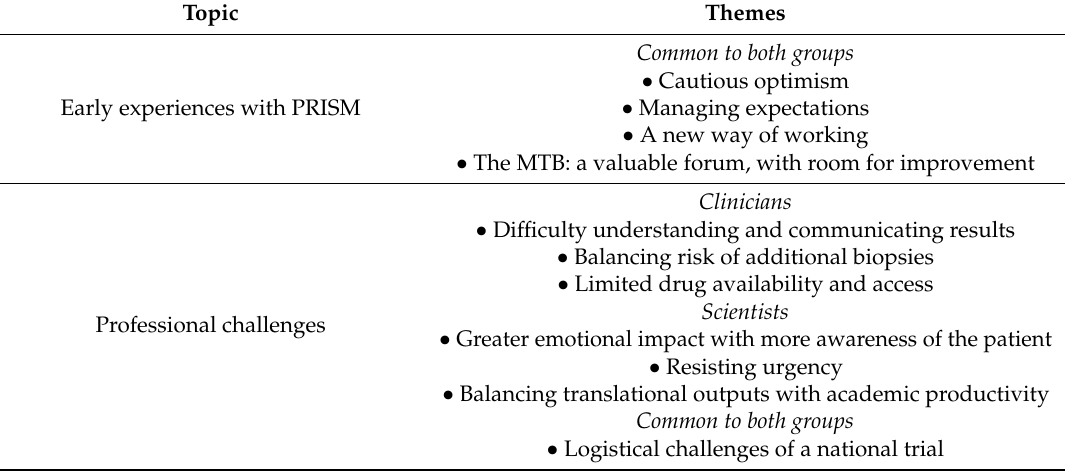
Table 2. Summary of themes from the clinician and scientist